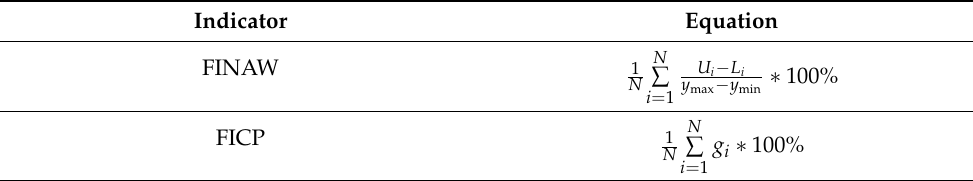
Table 4. Performance metrics used to evaluate forecast intervals.